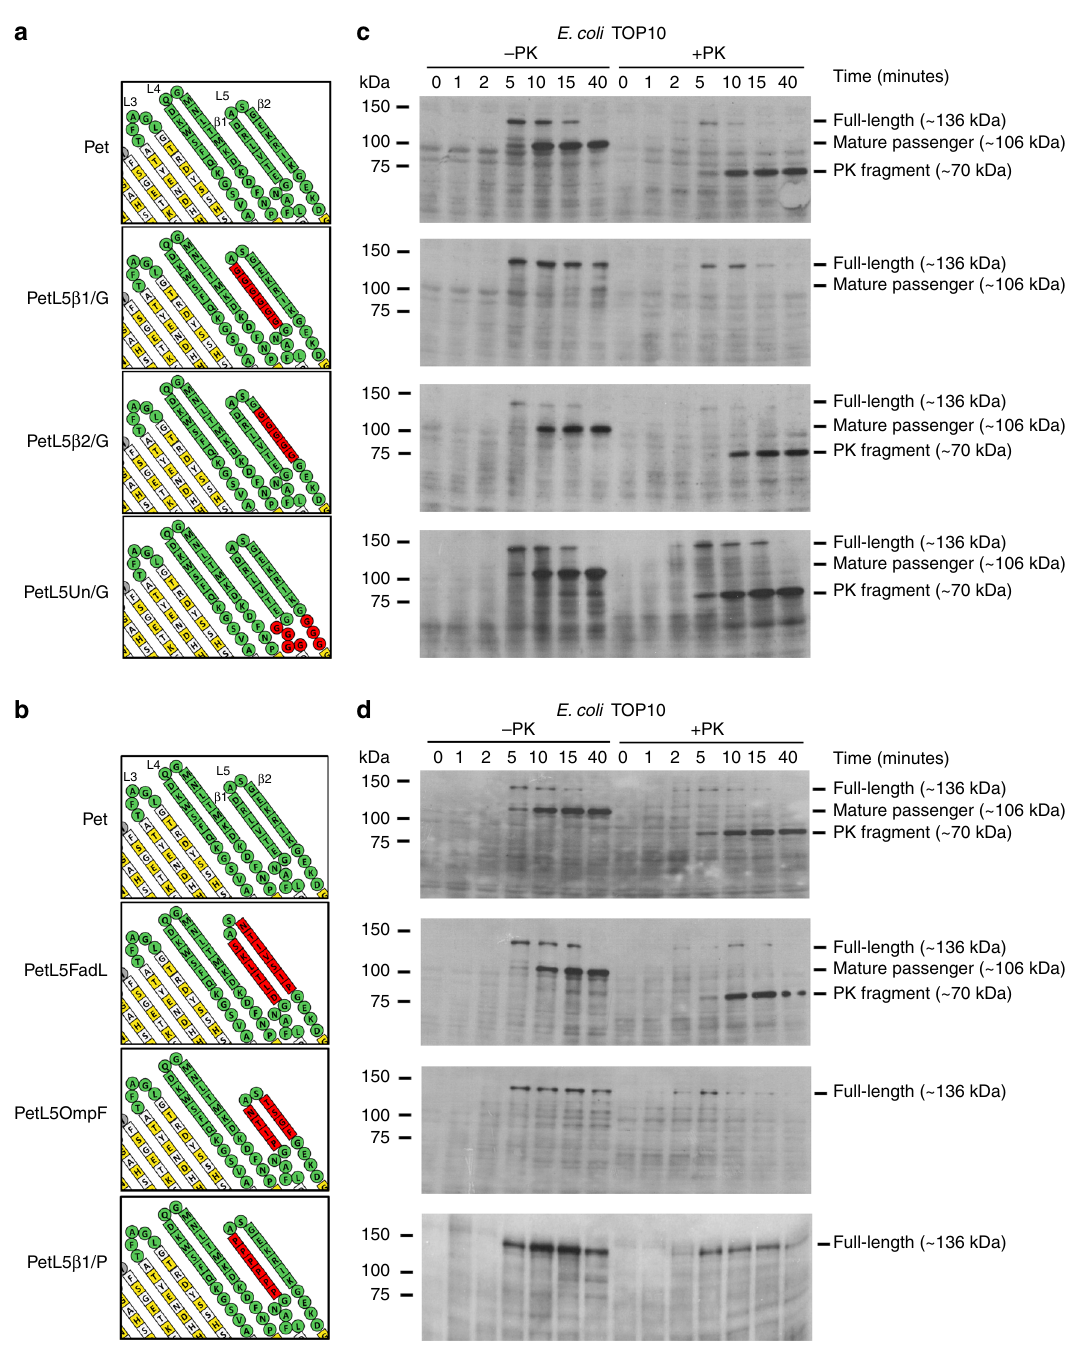
Fig. 2 L5 likely templates folding of the Pet passenger domain by β -strand augmentation. Topology model of the Pet β -barrel domain showing the Pet L5 β 1/G , Pet L5 β 2/G , and Pet L5Un/G ( a ), and the Pet L5FadL , Pet L5OmpF , and Pet L5 β 1/P ( b ) mutations (in red). Pulse-chase expression of Pet, Pet L5 β 1/G , Pet L5 β 2/G , and Pet L5Un/G ( c ), and of Pet, Pet L5FadL , Pet L5OmpF , and Pet L5 β 1/P ( d ), and sensitivity to proteinase K (PK) in E. coli TOP10 monitored by SDS-PAGE and immunoblotting with anti-Pet passenger domain antibodies. All samples were TCA precipitated prior to SDS-PAGE. Images are representative of at least two independent